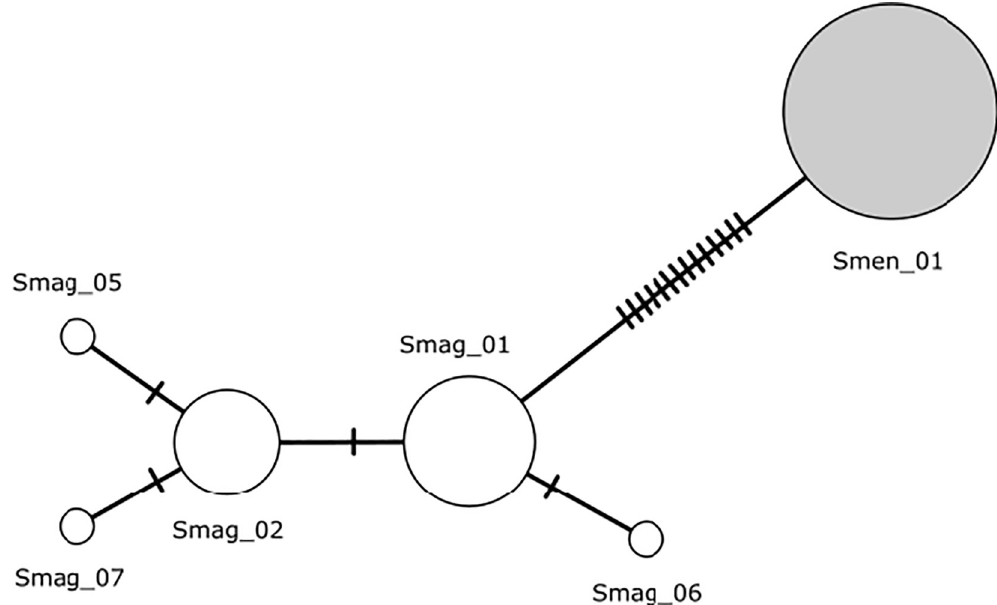
Fig 2. Haplotype network for mitochondrial cytochrome oxidase subunit I (COI) haplotypes detected in Magellanic and Gala´pagos penguins. The network was constructed under the TCS model in PopART [99]. Dashes along lines represent the number of changes from one haplotype to another. The size of the circle is proportional to the frequency of the haplotype. Magellanic haplotypes (white) are designated as Smag_# and the Gala´pagos haplotype (gray) is designated as Smen_1.